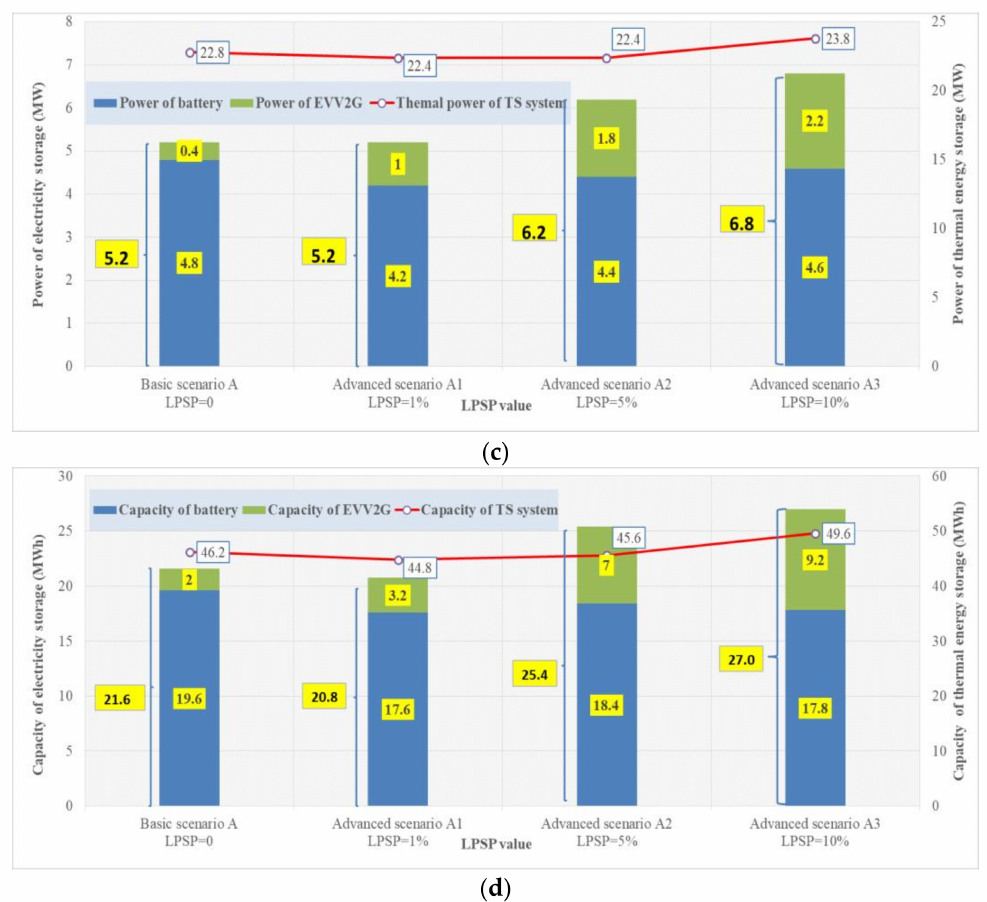
Figure 2. Change of MENR system with different LPSP values in Xizhou Town. Changes of MENR system with different LPSP values in Xizhou Town. ( a ) Change of solar and wind power system; ( b ) Change of solar thermal energy system; ( c ) Change for power of energy storage system; ( d ) Change for capacity of energy storage